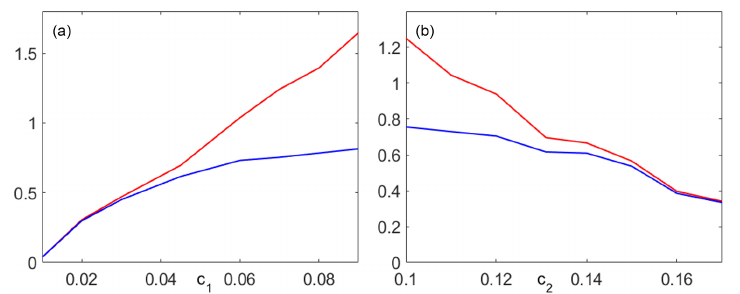
Figure 6. Simulated values of the total burned area (red curves) and of the burned area inside the perimeter of the fire scar (blue curves) in units of the total area inside the perimeter as a function of c 1 for fixed c 2 = 0 . 131 (a) and as a function of c 2 for a fixed c 1 = 0 . 045 (b)